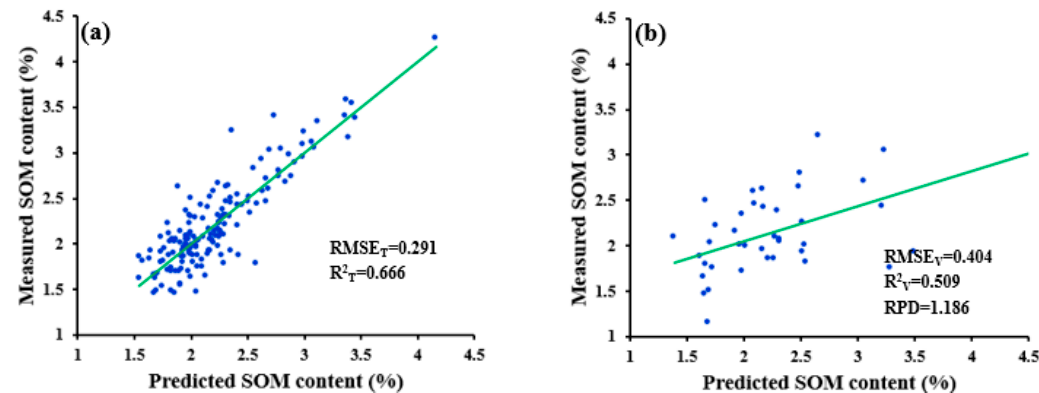
Figure 7. SOM content estimation results based on PLSR for ( a ) training and ( b ) validation set for data subjected to WPD-1/R-NDR pretreatment.